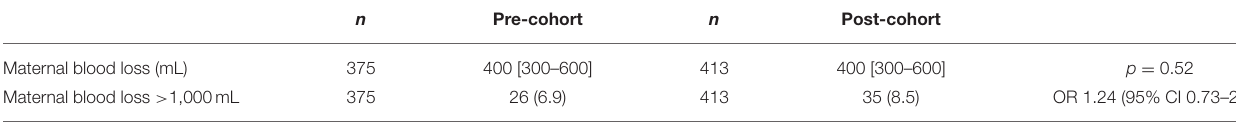
n Pre-cohort n Post-cohort